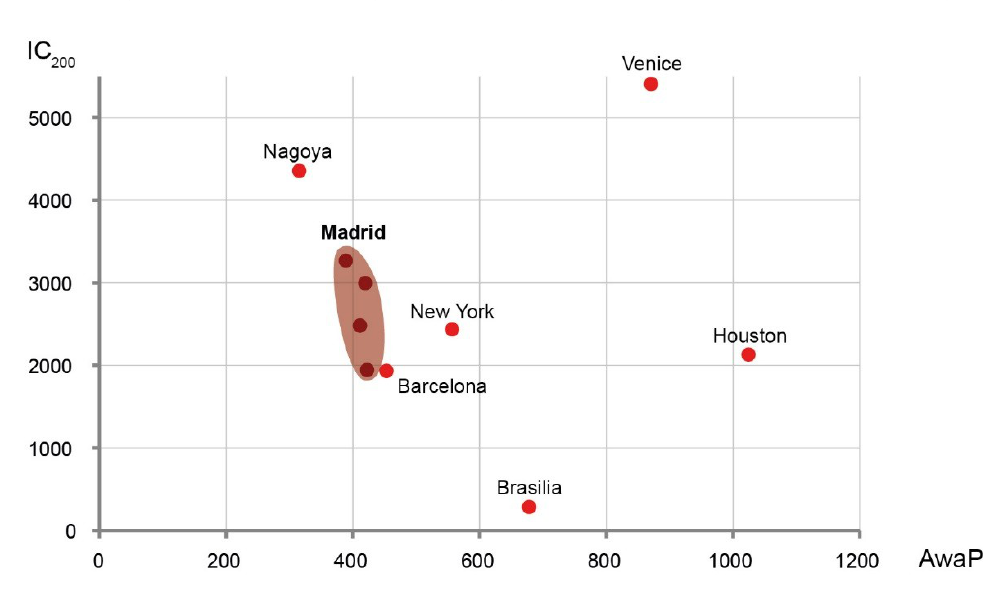
Figure 7. AwaP-IC variation in Madrid compared to other cities.